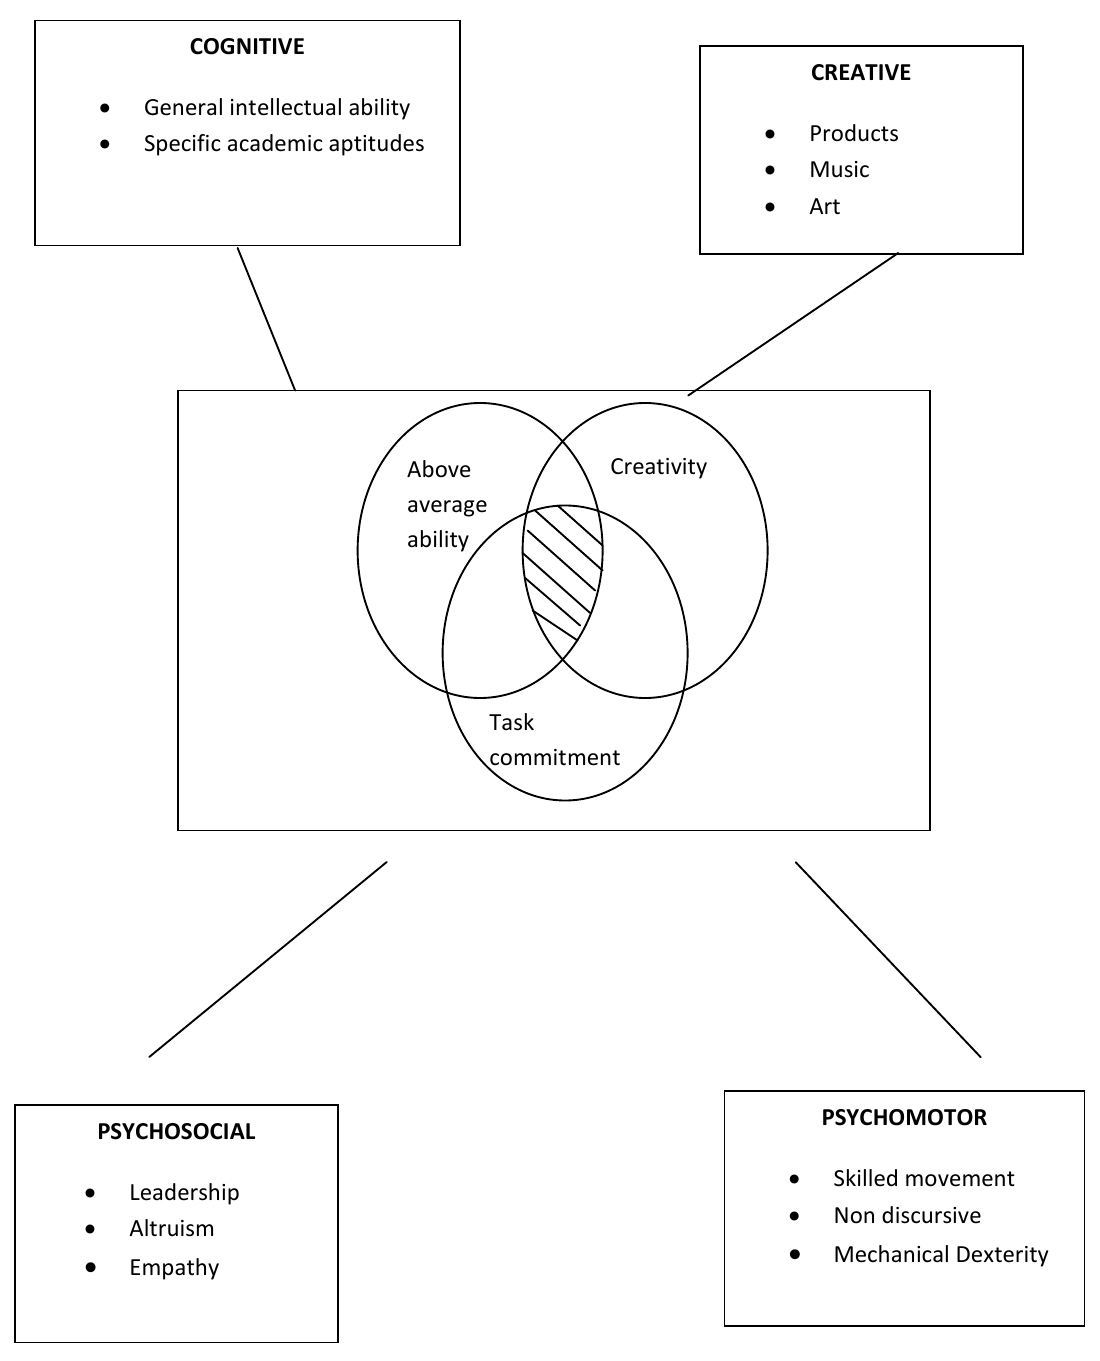
Figure 2.3: (Renzulli’s Three -Ring Model 1986, adapted from Hennessey,